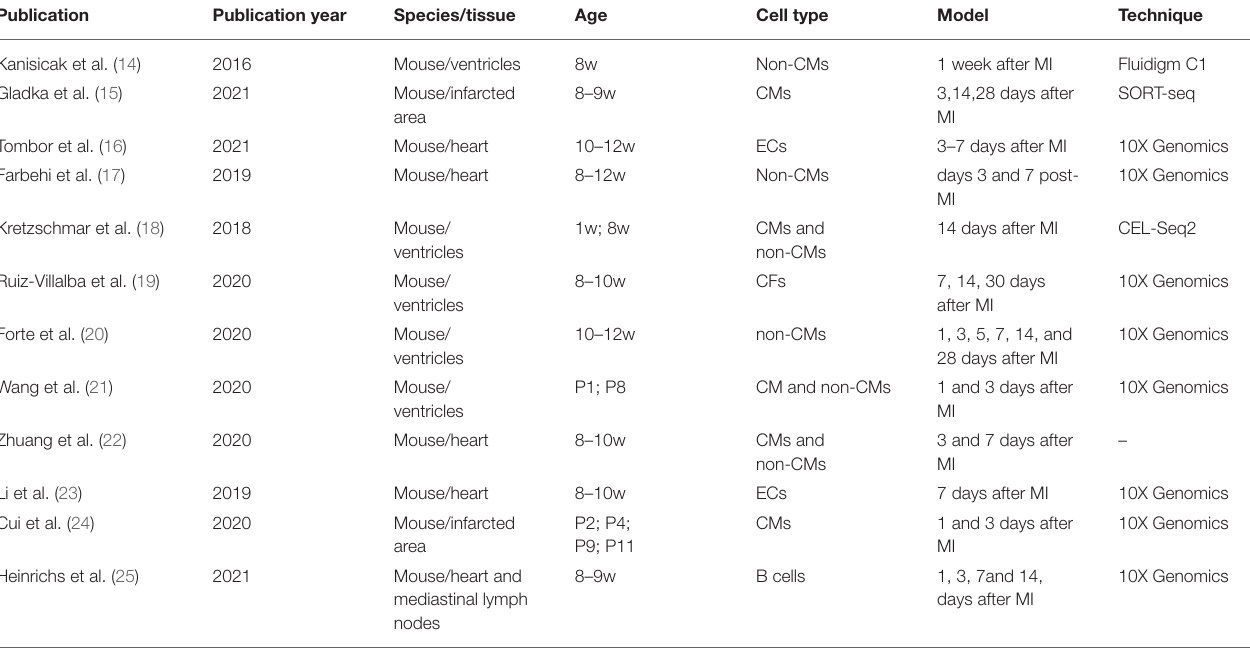
TABLE 1 | Application of single cell sequencing technology in the study of myocardial